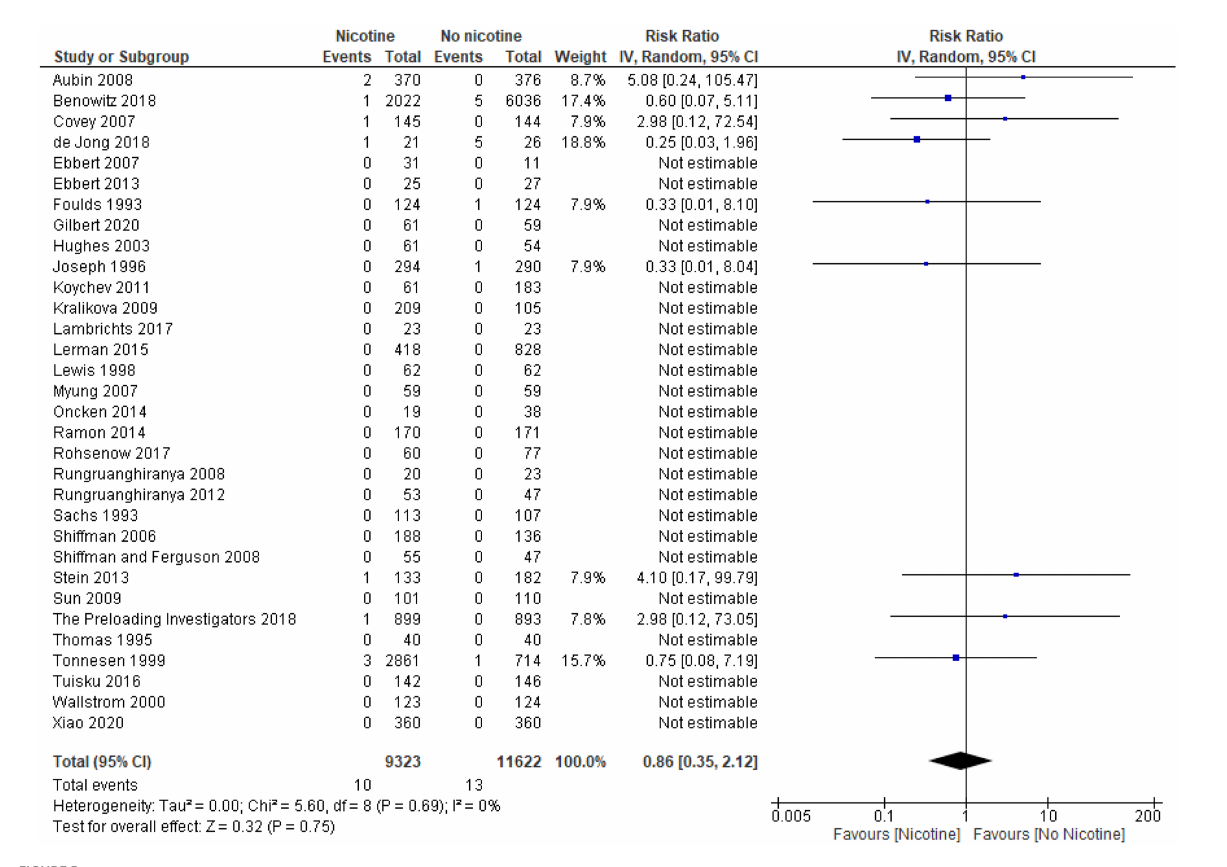
FIGURE 5 Forest plot, meta-analysis for nonfatal myocardial